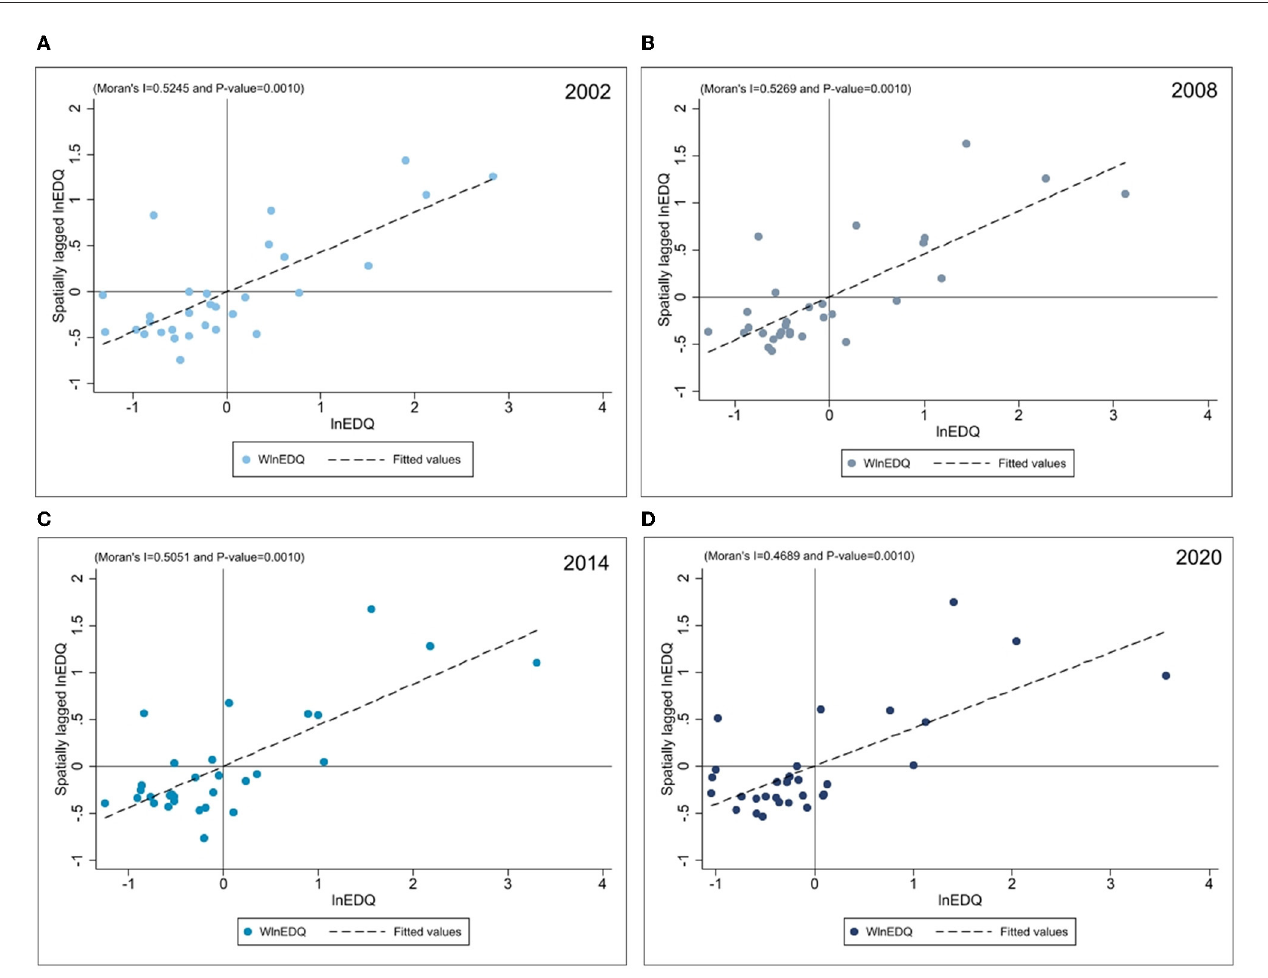
FIGURE2 (A–D) Local Moran’s index scatters